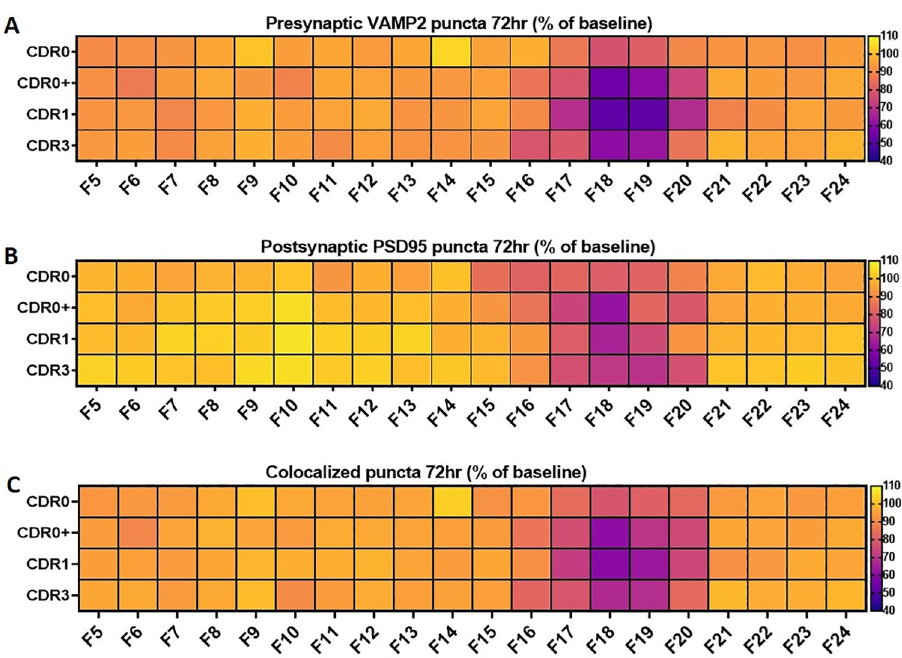
Fig 4. Heatmaps of synaptotoxic activities in each SEC fractions from control and AD case groups at 72 hours. Scatterplots of synaptotoxic activities of each individual subject is shown in S3 Fig. (A) Comparison of presynaptic VAMP2 synaptotoxic activities among control and AD case groups at 72 hours; significant VAMP2 loss were found in wells incubated with lysate fractions 17 to 20; several fractions from CDR0+ and CDR1 showed statistically more VAMP2 loss than from CDR0; (B) Comparison of postsynaptic PSD95 synaptotoxic activities among control and AD case groups at 72 hours. Loss of PSD95 post synaptic puncta was found in wells incubated with lysate fractions 17 to 20. Fraction 18 from CDR0+ and CDR1 brain homogenates caused more PSD95 postsynapse loss than fraction 18 from CDR0 brains. Fraction 19 from CDR3 brain homogenates caused more PSD95 postsynapse loss than fraction 19 from CDR brains. (C) Comparison of colocalized pre and post synaptic puncta among control and AD case groups at 72 hours; loss of colocalized synaptic puncta were found in wells incubated with fractions 17 to 20. Fractions 17–19 from CDR0+ and CDR1 brain homogenates caused more colocalized synaptic puncta loss than comparable fractions from CDR0 brains.